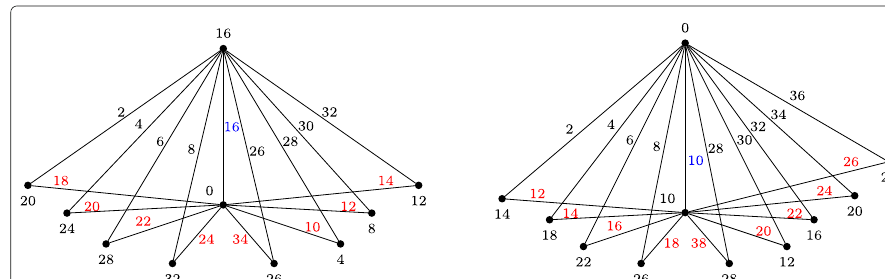
Fig. 2 An edge even graceful labeling of K 1 + K 1,8 , and K 1 + K 1,9